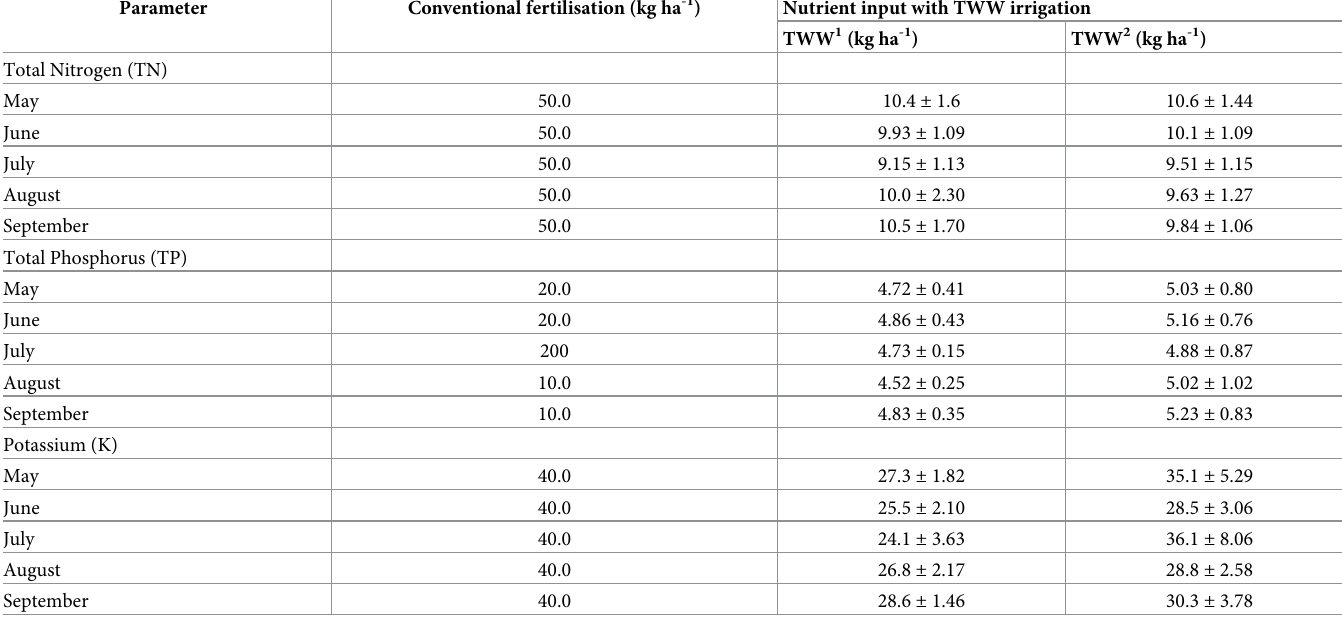
Table 9. Nitrogen, phosphorus and potassium inputs provided by treated wastewater irrigation during 2016–2018. For each planted unit and month of growth, aver- age values ( ± standard deviation) are